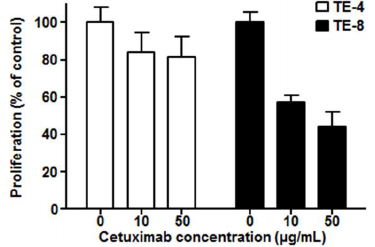
Figure 3. Cytotoxicity of cetuximab on TE-4 (low EGFR expression) and TE-8 (high EGFR expression) cells after five days of cetuximab treatment at each dose. The viable cell number was counted by ADAM cell counter. Data presented as the percentage (%) of viable cell number compared to the control.